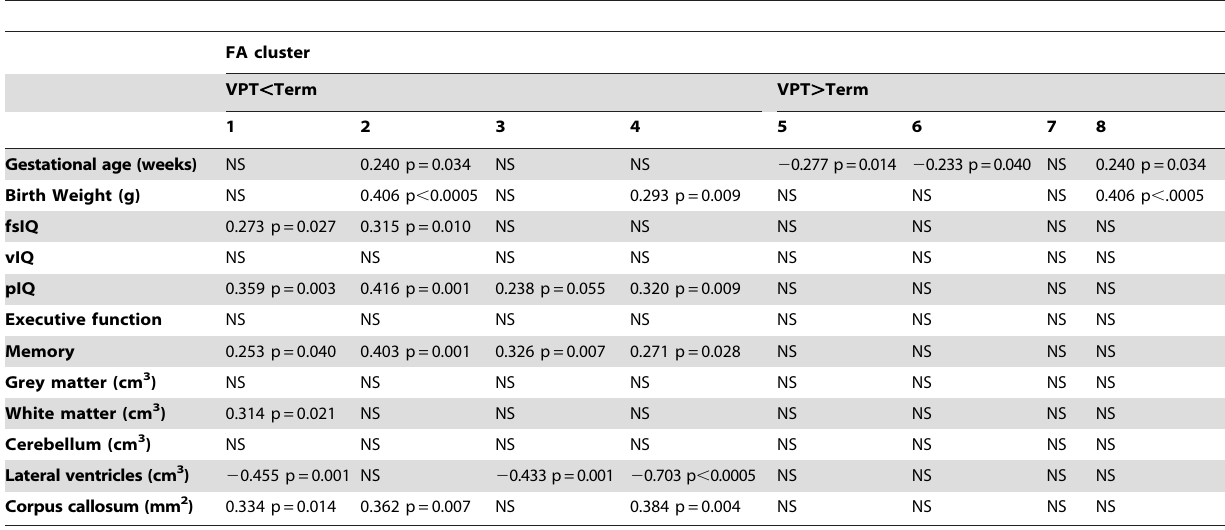
Table 3. Correlations between FA and perinatal, neuropsychological and neuroimaging variables.